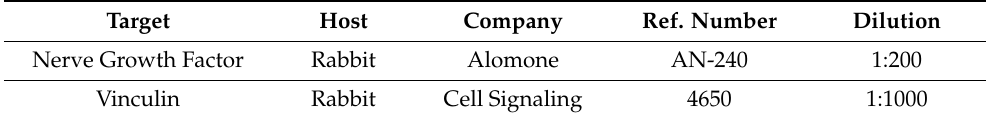
Table 2. List of primary antibodies used for biochemical analyses. Target Host Company Ref.